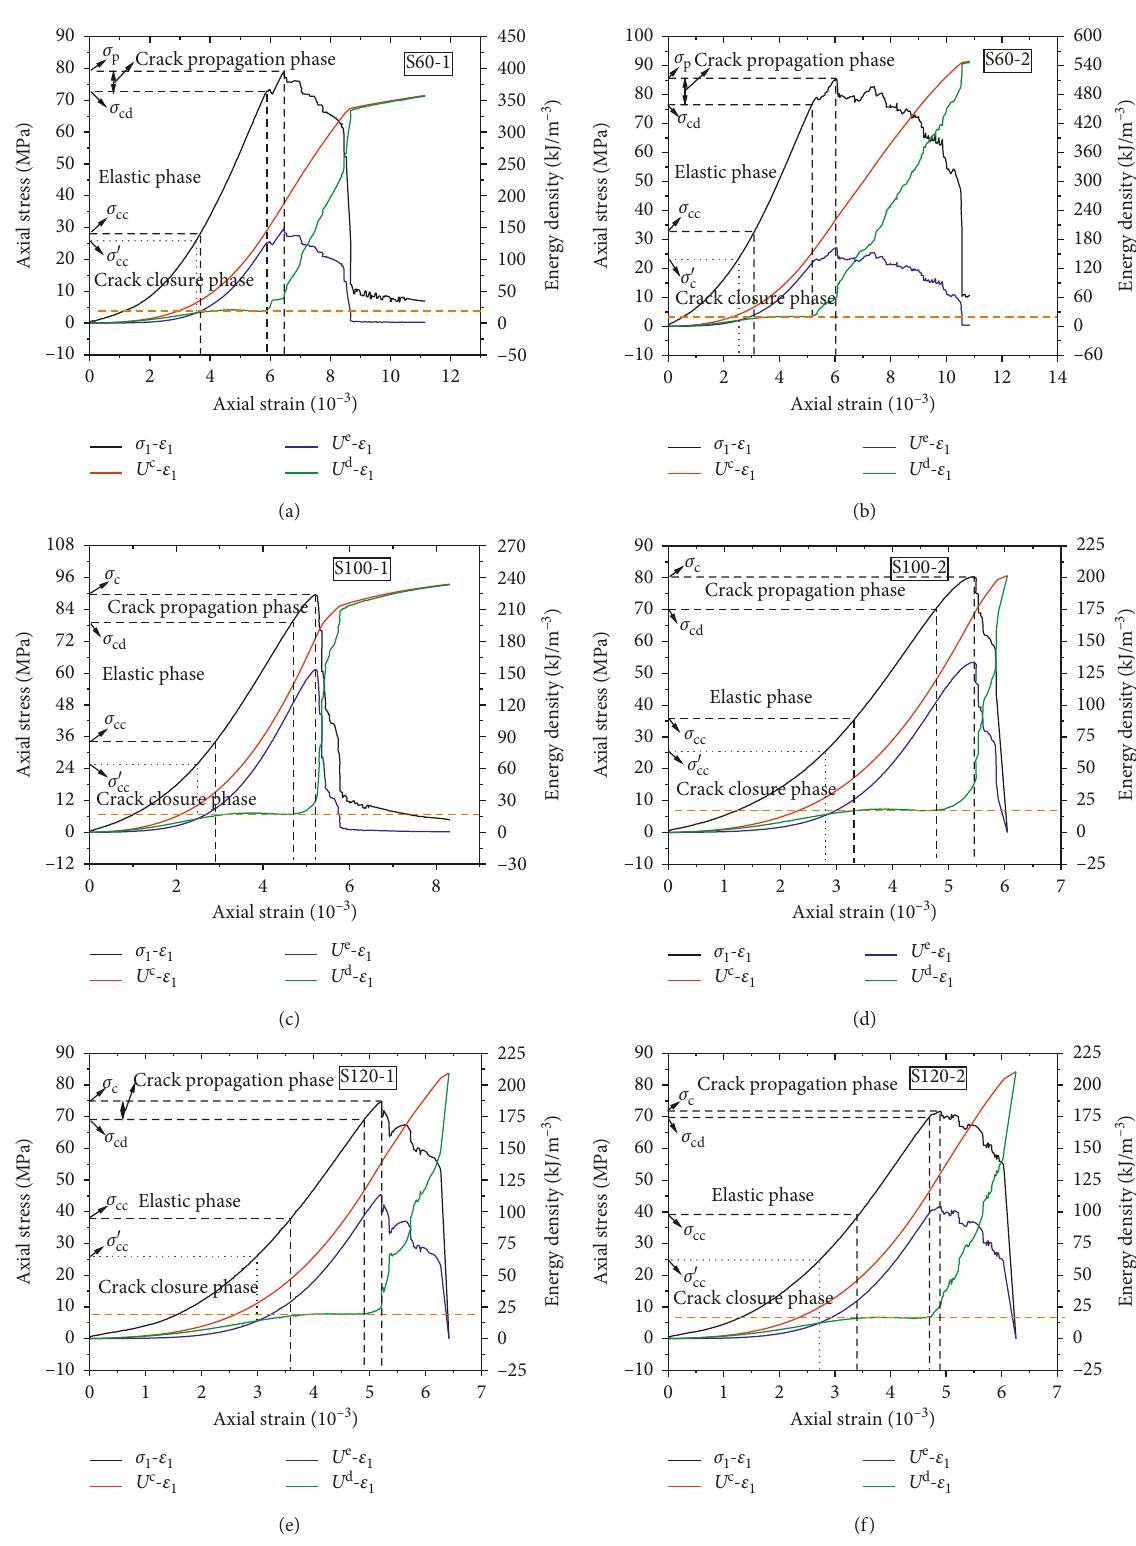
Figure 9: Energy evolution characteristics of the sandstone specimens with different H / D